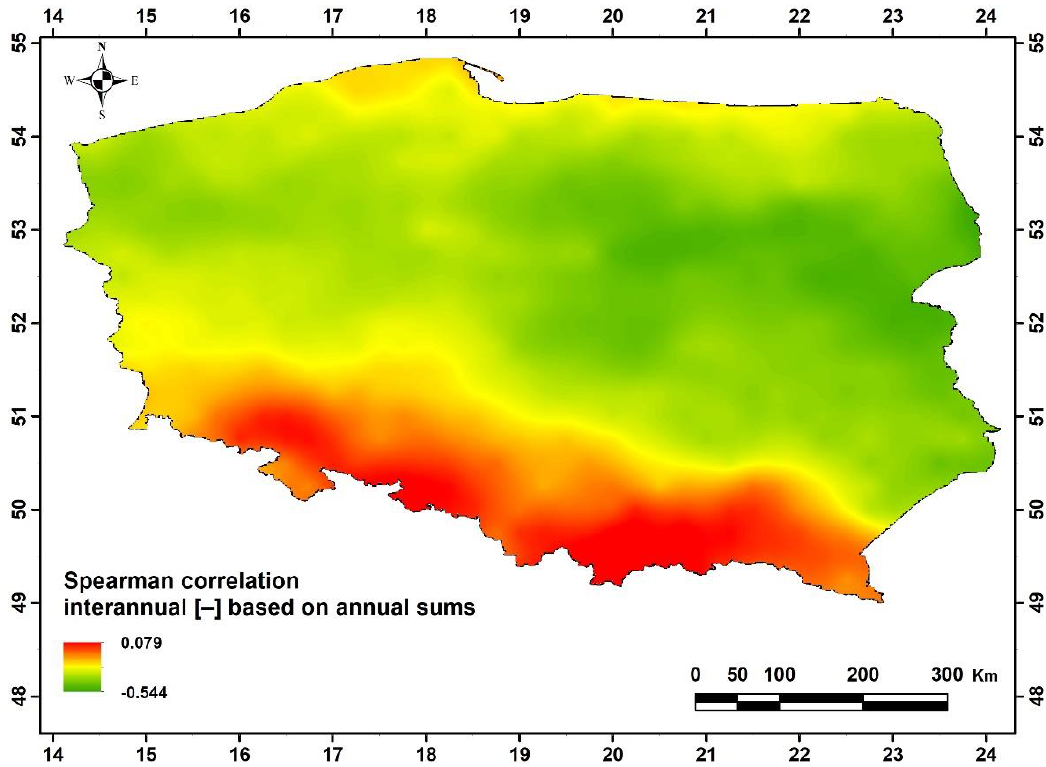
Figure 6. Interannual correlation between solar and wind resources across Poland, based on annual sums of resources availability, 1980 – 2019.